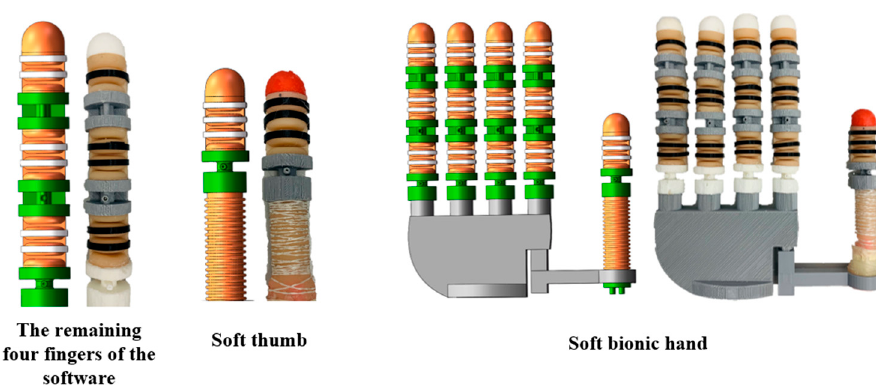
Figure 5. Single finger production process.